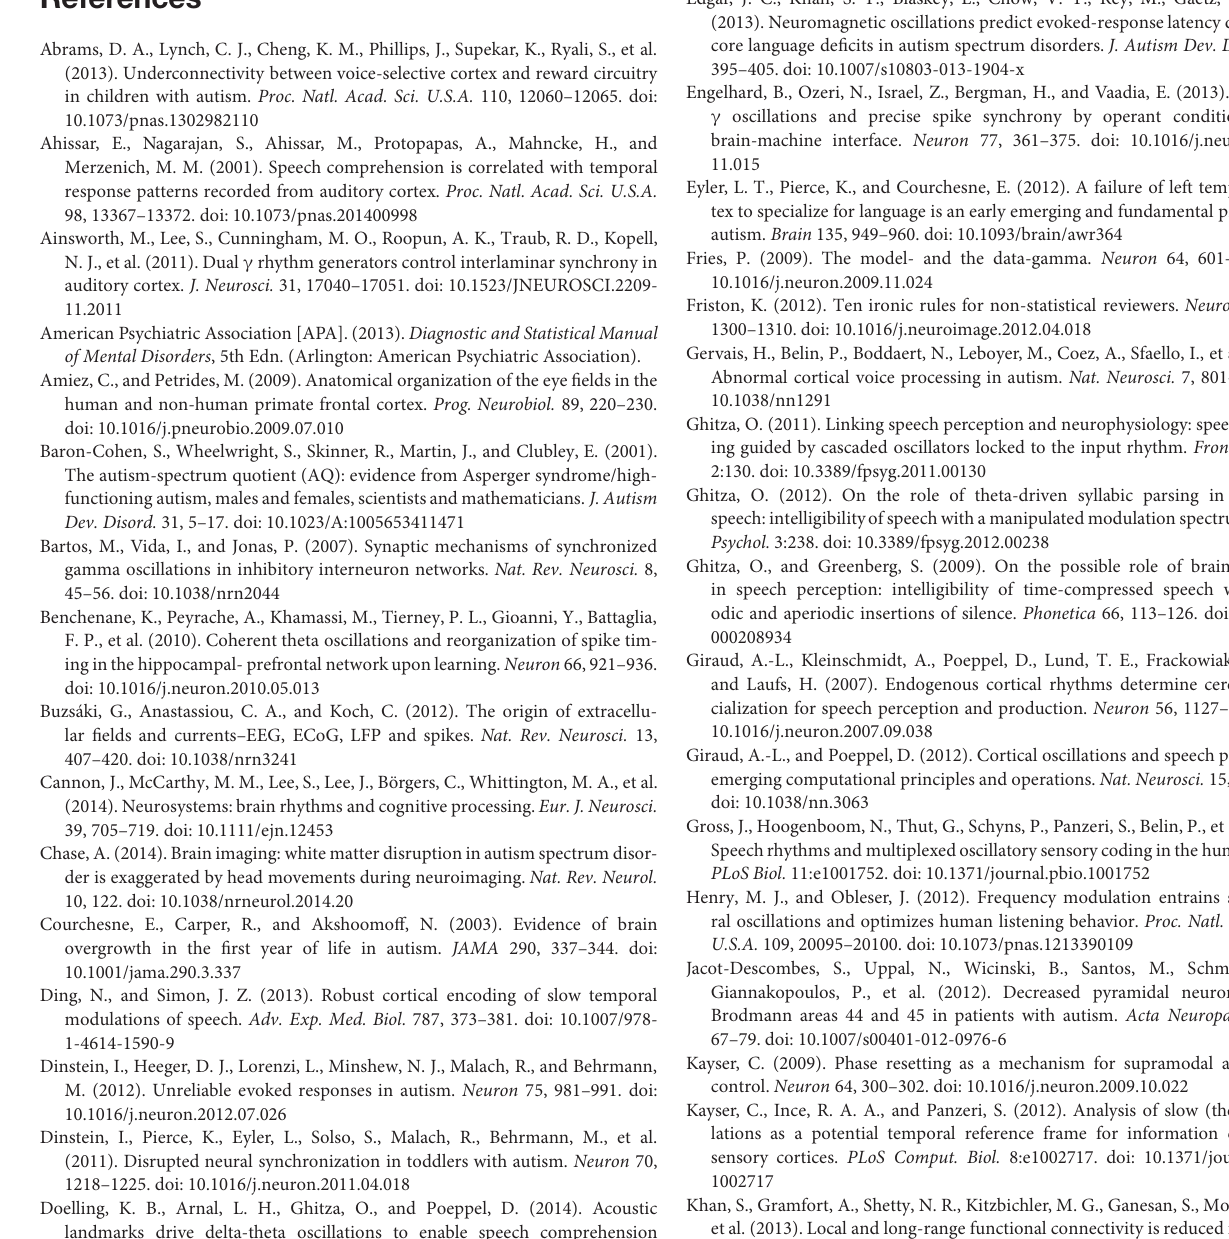
Figure S2 | (A) Neural activity (fMRI only, top panels) in subjects with autism (right) and controls (left) during audio-visual presentation of the documentary ( p < 0.05, corrected). (B) Partial correlations between the EEG power spectrum (1–70 Hz) and fMRI data at the left hemispheric locations where we found reduced (auditory cortex) and enhanced (visual cortex) neural activity. Note that, unlike the effect in left auditory cortex, the effect in the right posterior superior temporal sulcus is not explained by differences in EEG-BOLD